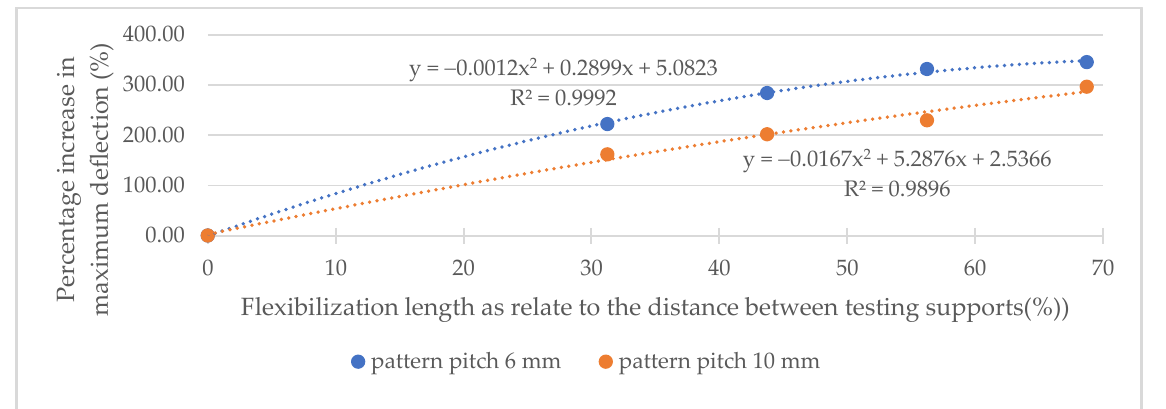
Figure 15. Correlations between percentage change in the MOR with changes in the flexibilization length, for two values of the kerfing pitch.